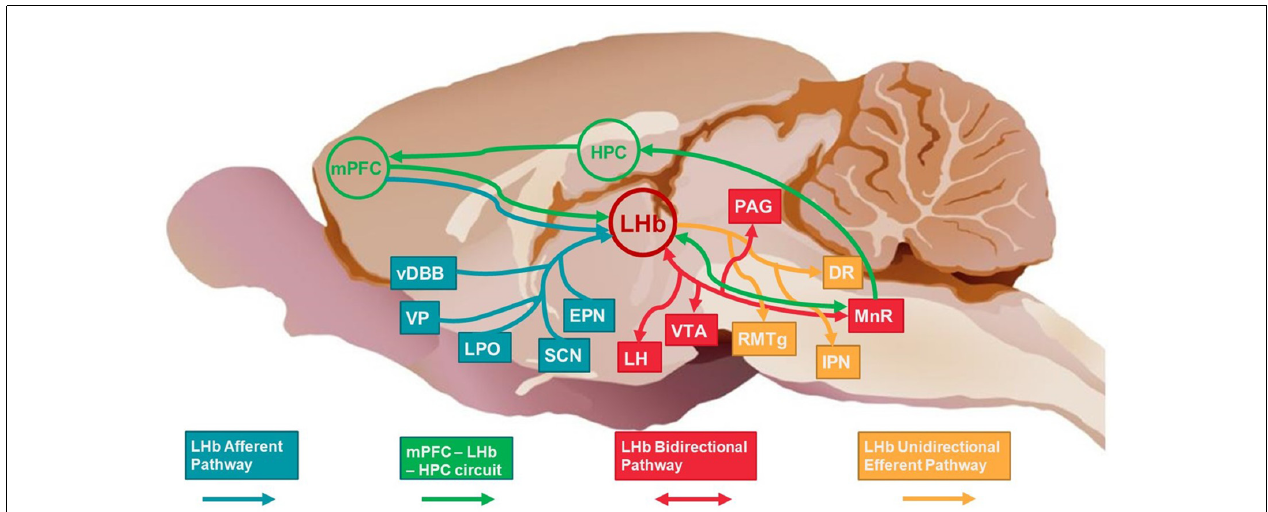
FIGURE 1 | Schematic of selected afferent, bidirectional and efferent pathways of LHb (red circle) and the broader HPC-mPFC-LHb circuit. Afferent structures/pathways are shown in blue, bidirectional structures/pathways are shown in red, efferent structures/pathways are shown in yellow. The mPFC-LHb-HPC circuit structures/pathways are shown in green. LHb, lateral habenula; HPC, hippocampus; mPFC, medial prefrontal cortex; vDBB, vertical diagonal band of Broca; VP, ventral pallidum; LPO, lateral preoptic area; SCN, suprachiasmatic nucleus; EPN, entopeduncular nucleus; LH, lateral hypothalamus; VTA, ventral tegmental